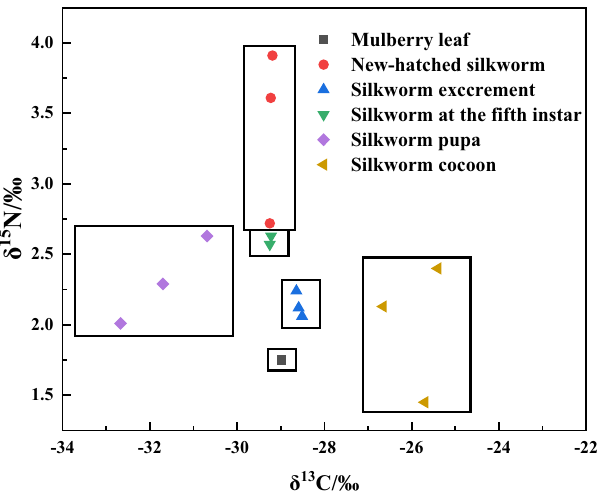
Figure 5. Distribution map of carbon and nitrogen stable isotope composition in samples.